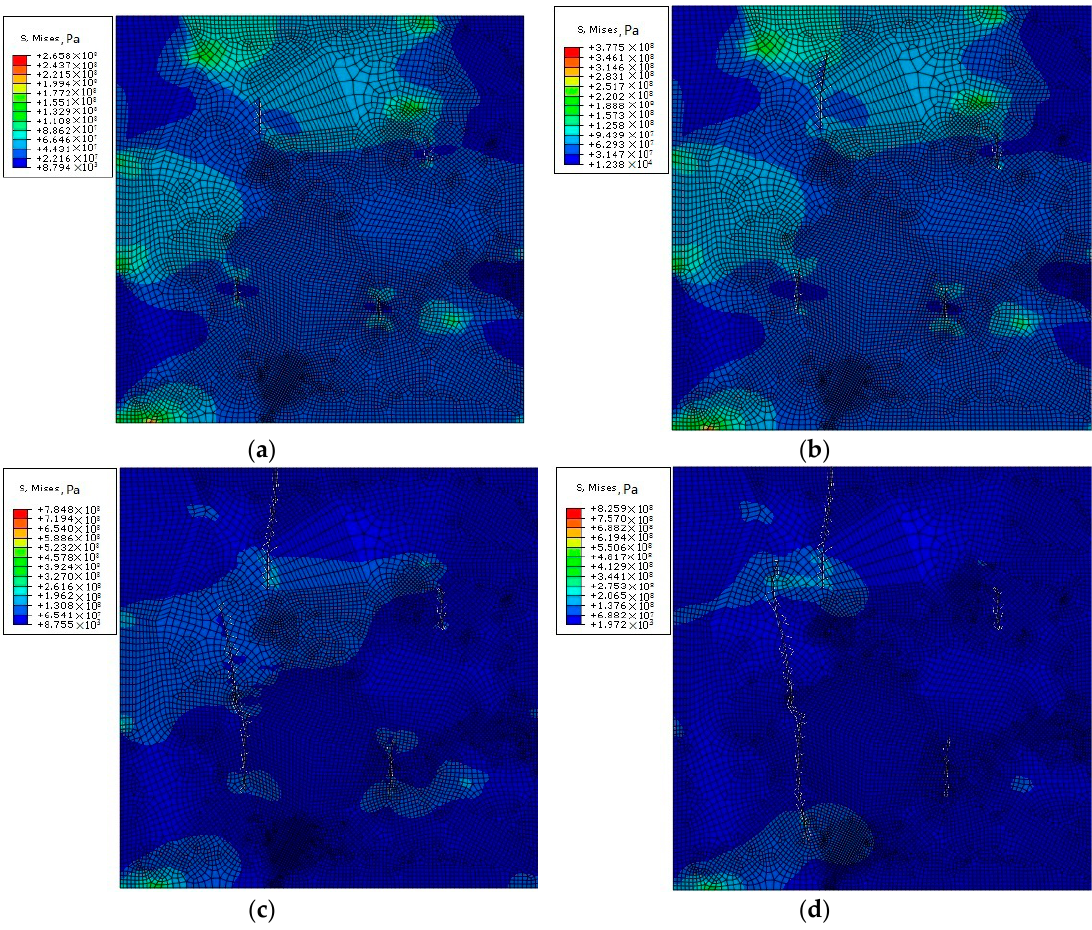
Figure 16. The ( a ) first stage, ( b ) second stage, ( c ) third stage, and ( d ) fourth stage of crack propagation with a load direction of 90°.